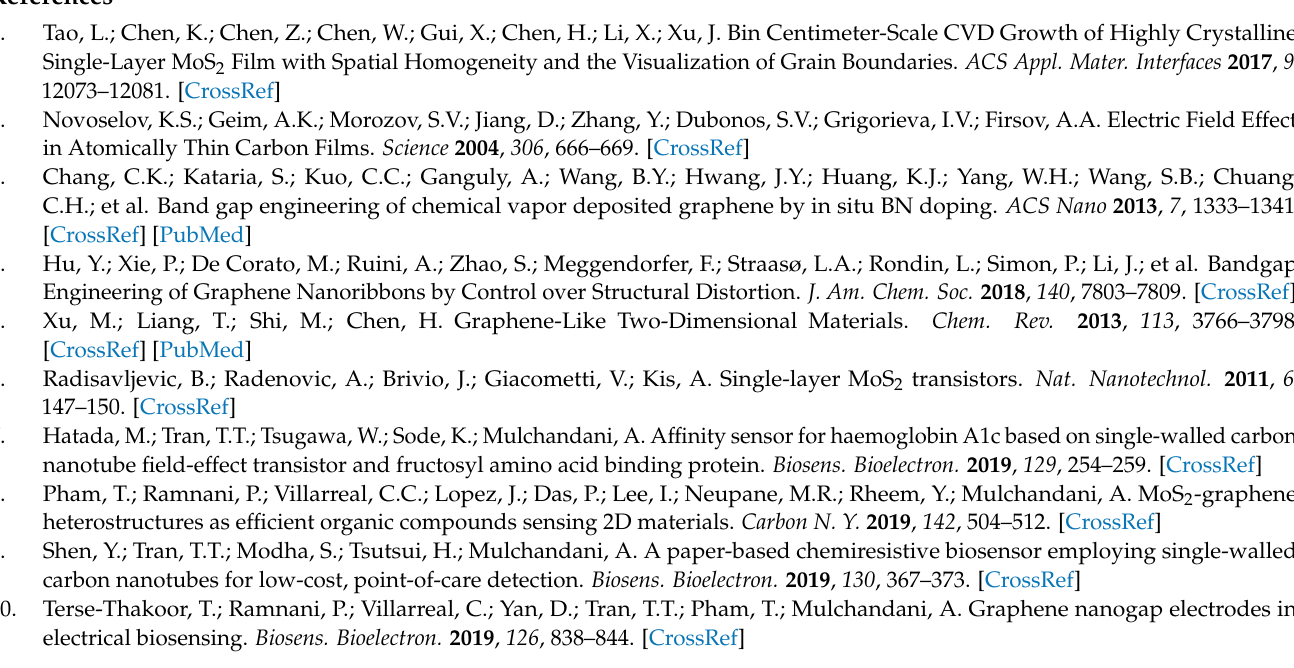
water. Figure S2: S1813-MoS 2 -based device (a) schematic and (b) field-effect transistor characteristics after in DI water (pH = 7). Figure S3: SEM image of same location (a) before; (b) after 10 min incubation in 5 mM AuCl 3 solution. Figure S4: Schematic of MoS 2 -based FETs with Al 2 O 3 passive layer. Figure S5: Optical image of the sensor (a) before and (b) after Al 2 O 3 deposition. (c) L1: SiO 2 and L2: Al 2 O 3 thickness measured by ellipsometer. Table S1: Performance summary of MoS 2 -based FET